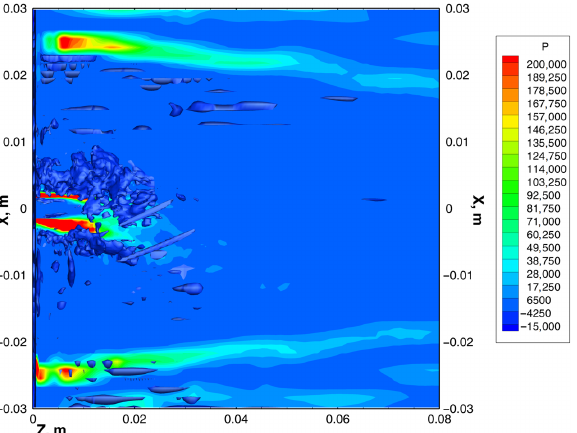
Figure 14. Production of subgrid stresses field and iso-surface where P = − 1700 m 2 /s 3